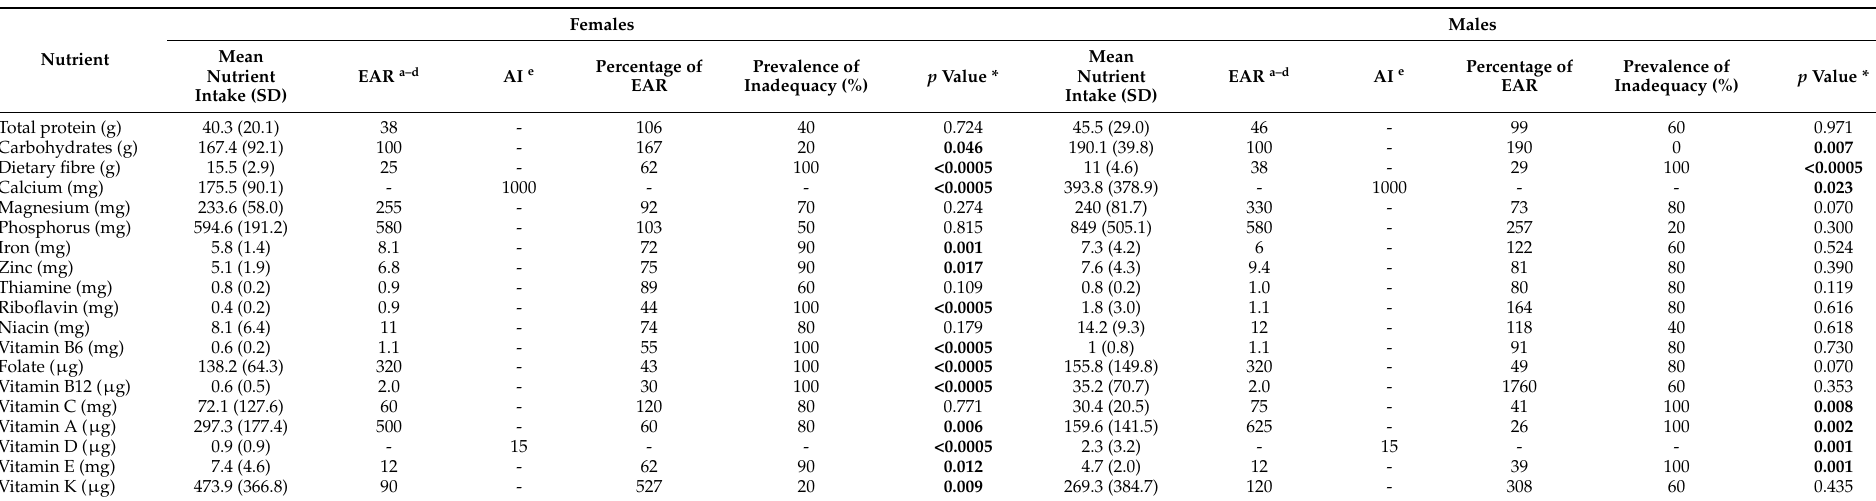
Table 7. Comparison of mean nutrient intake with the EAR/AI from two 24 h repeated recalls for female adults above 70 years (n = 10) and male adults above 70 years (n = 5).